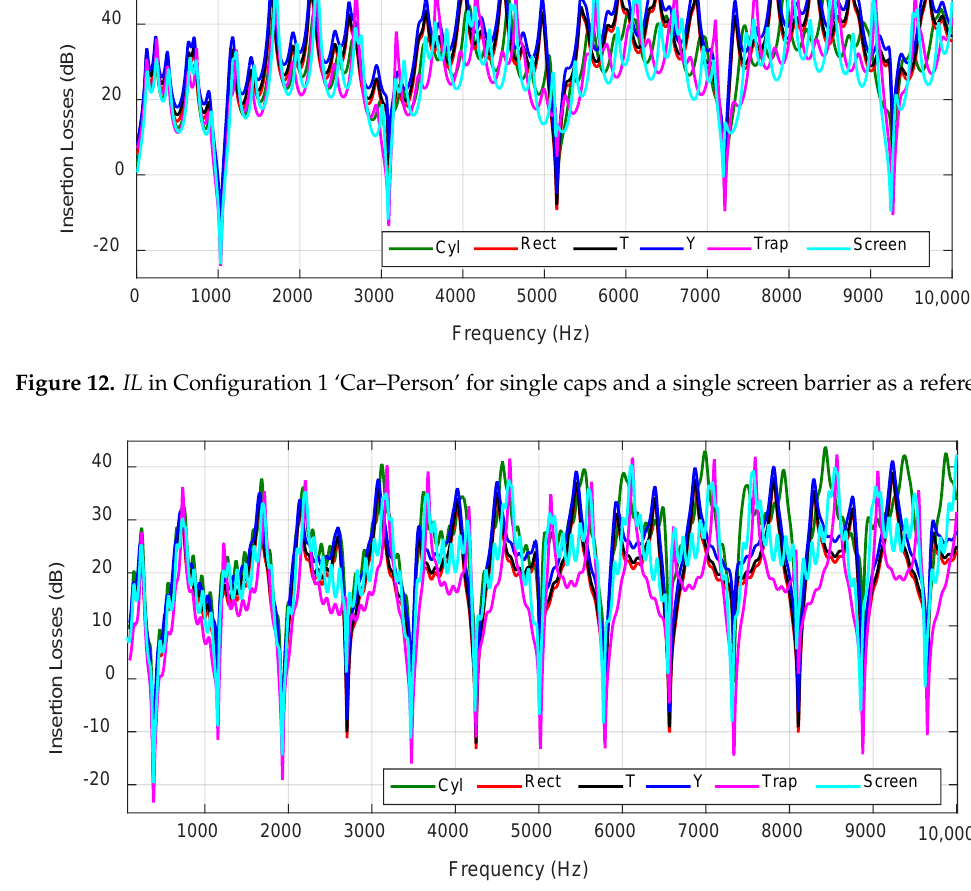
Figure 13. IL in Configuration 2 ‘Car–Balcony’ for single caps and a single screen barrier as a reference.